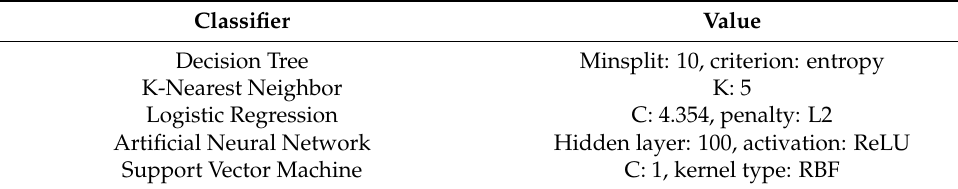
Table 3. Parameter configuration of the base